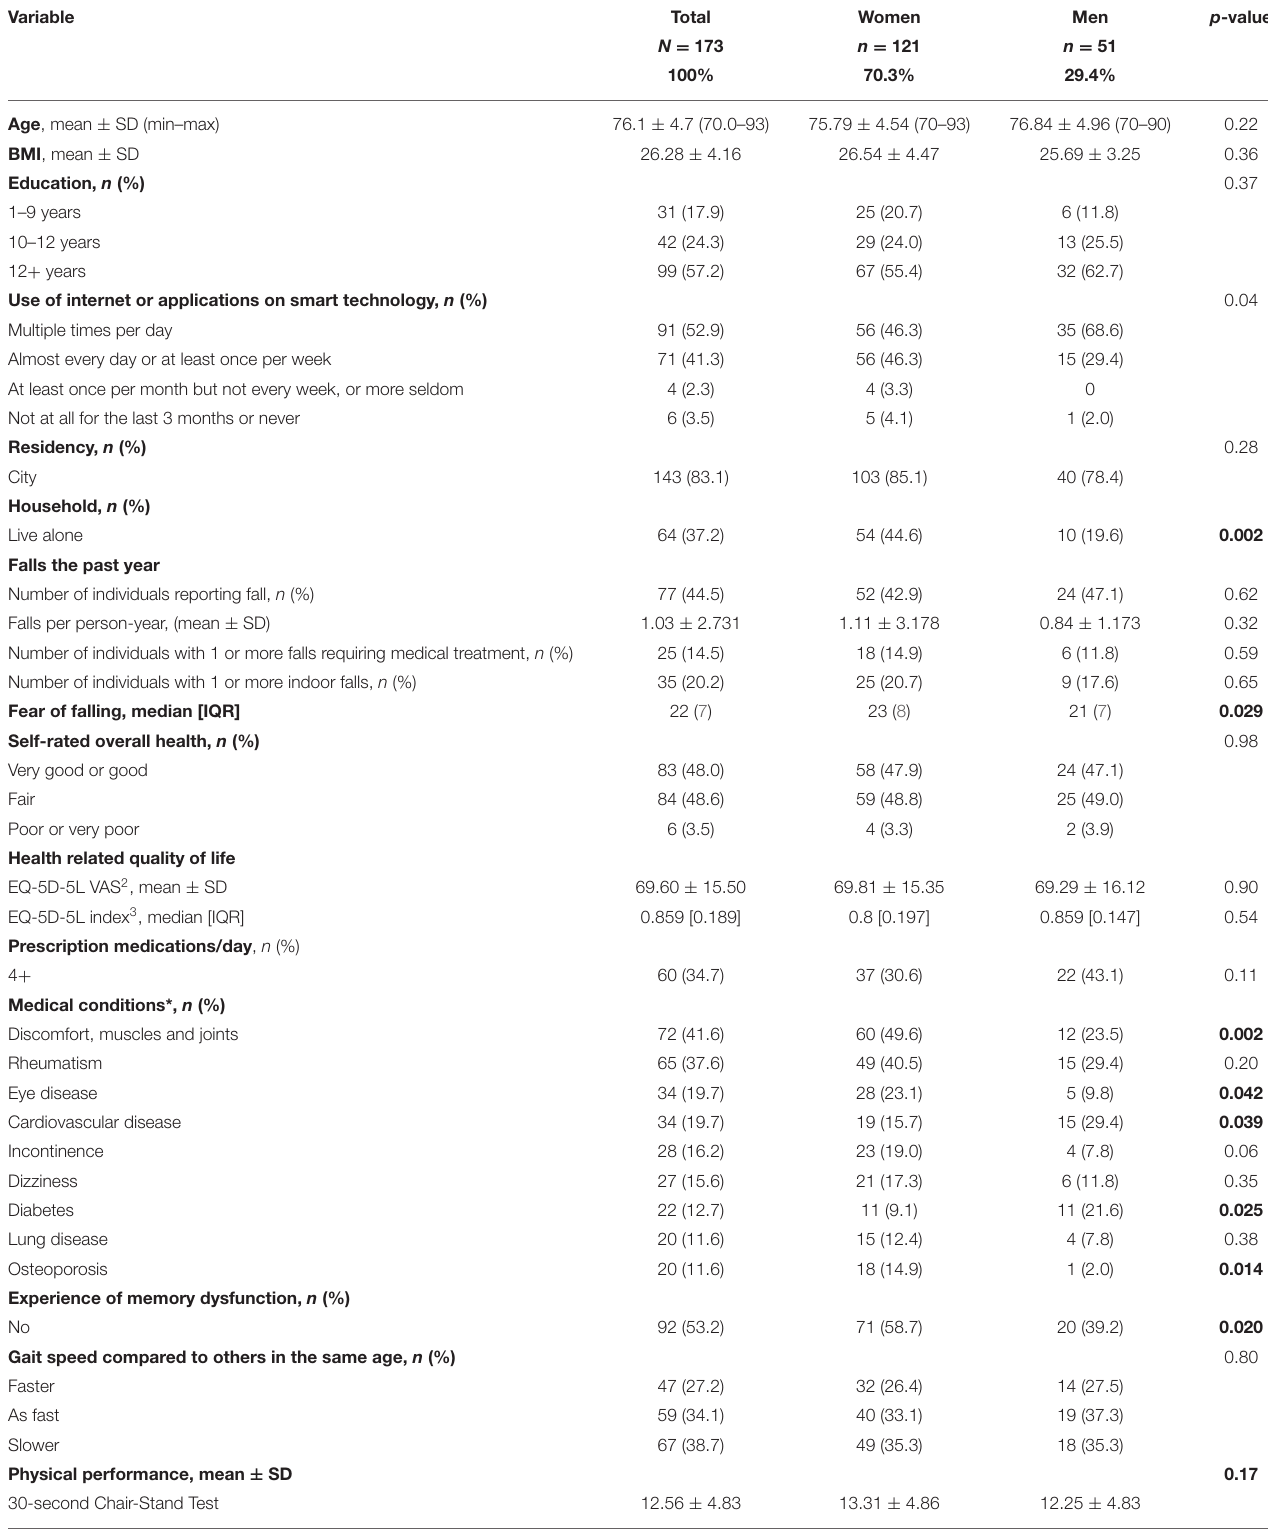
TABLE 1 | Participant’s